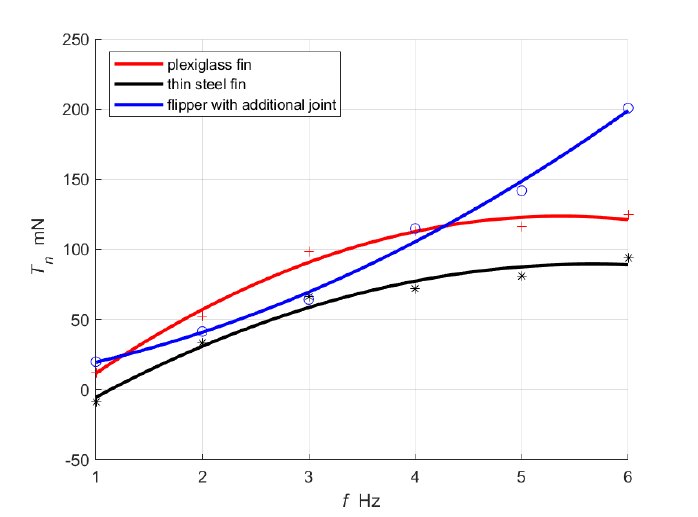
Figure 12. The mean net thrust generated by fins for different frequencies and fluid velocity u = 0.1